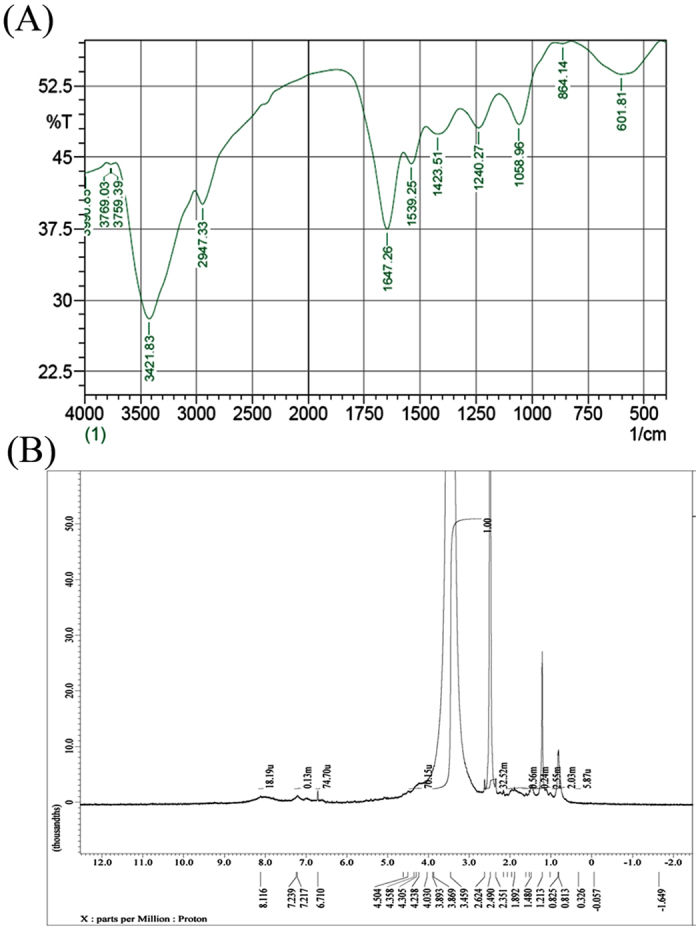
(A) FT-IR Spectroscopic analysis of the extracted melanin pigment; (B) NMR spectrum of the extracted melanin pigment.